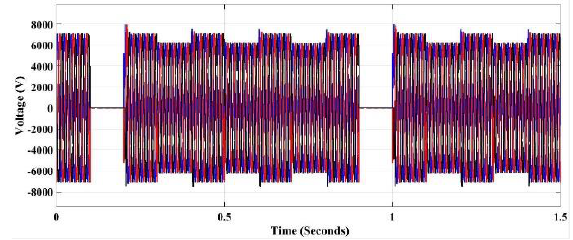
Table 3 Sequence Voltage, Current Readings, and